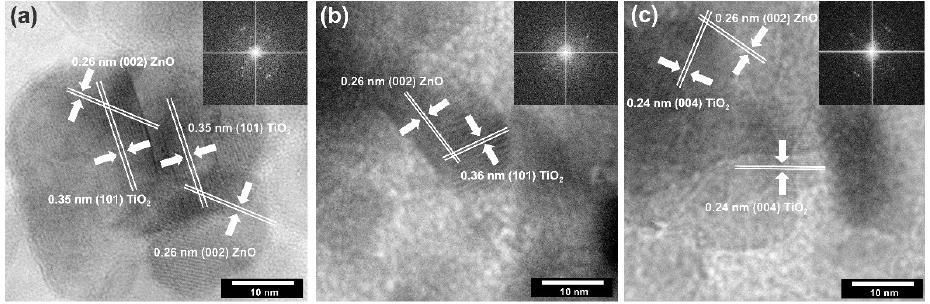
Figure 7. The HRTEM and FFT images for: ( a ) TiO 2 -(5%)ZnO; ( b ) TiO 2 -(10%)ZnO; ( c ) TiO 2 -(15%)ZnO.